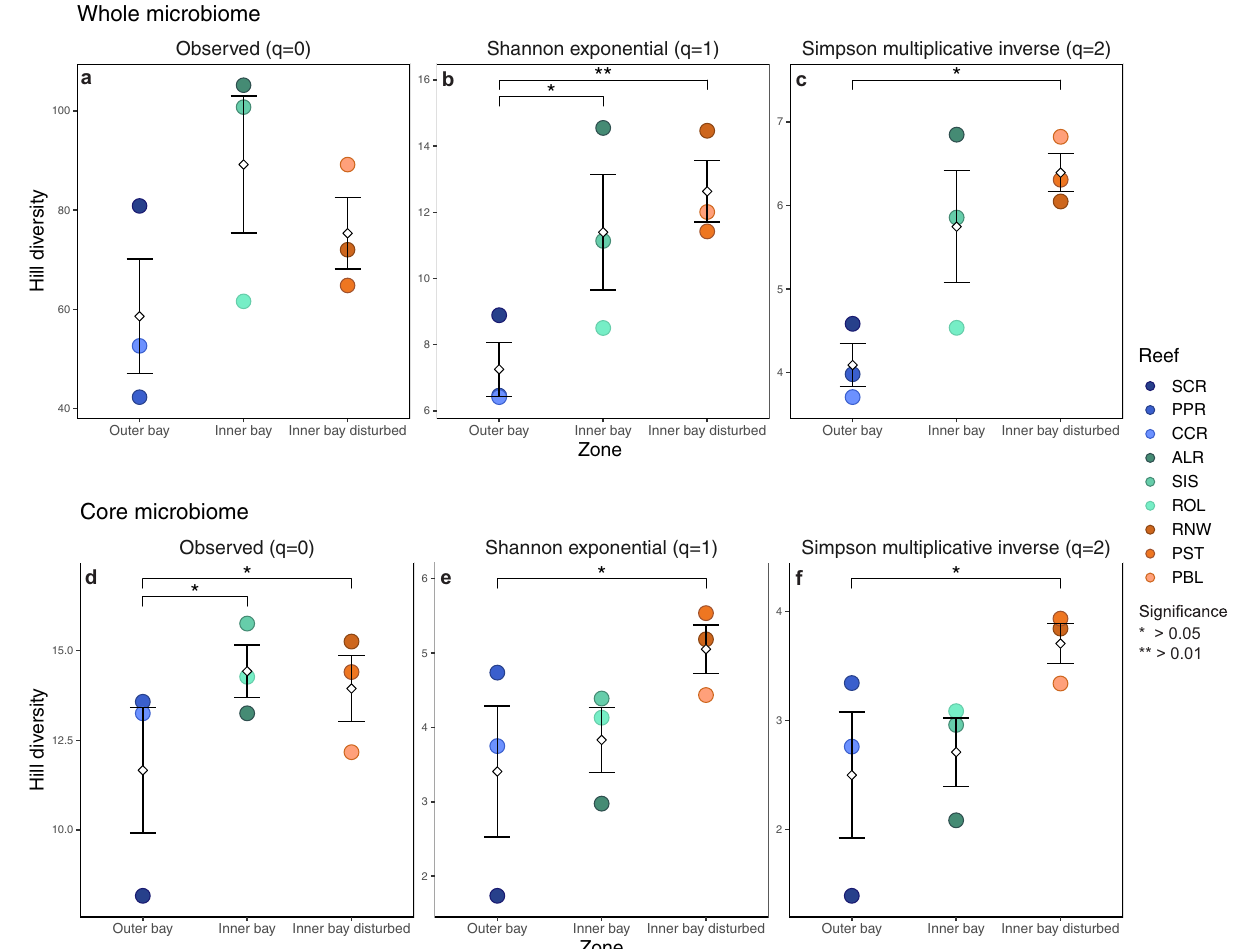
Fig. 3 Alpha diversity. Differences in diversity (mean ± SE) of ASVs between the whole gut microbiome ( a – c ) and the core gut microbiome ( d – f ) of Chaetodon capistratus across reefs. Alpha diversity was measured based on Hill numbers using three metrics that put more or less weight on common species. The observed richness ( a , d ) does not take into account relative abundances. Shannon exponential ( b , e ) weighs ASVs by their frequency. Simpson multiplicative inverse ( c , f ) overweighs abundant ASVs. Signi fi cance depicts differences in alpha diversity among reef zones (Kruskal – Wallis test with post hoc Dunn test). Diamonds depict